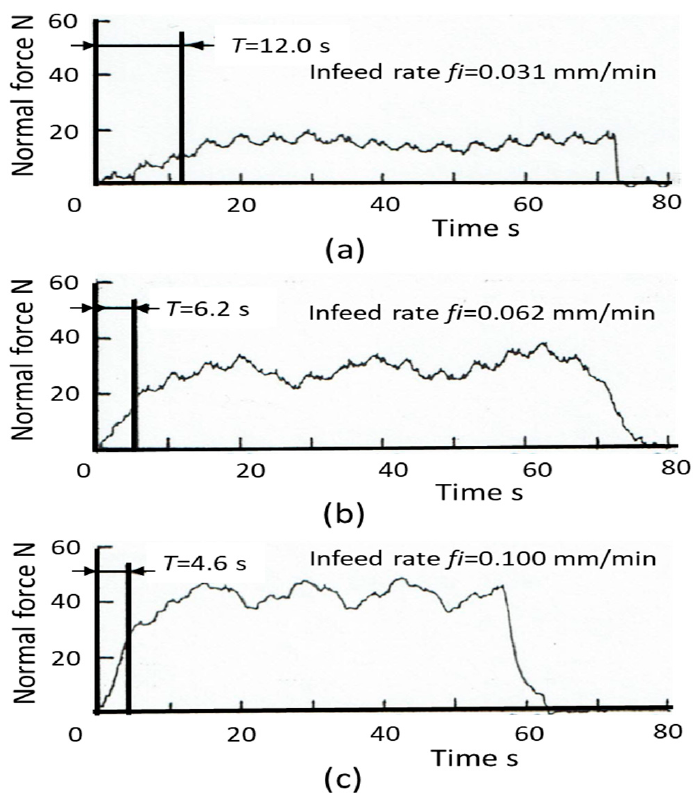
Figure 22. Experimental results of plunge centerless grinding and the time constant. ( a ) Q w (cid:48) = 0.01 mm 3 / mm · s; ( b ) Q w (cid:48) = 0.02 mm 3 / mm · s; ( c ) Q w (cid:48) = 0.0325 mm 3 / mm · s.